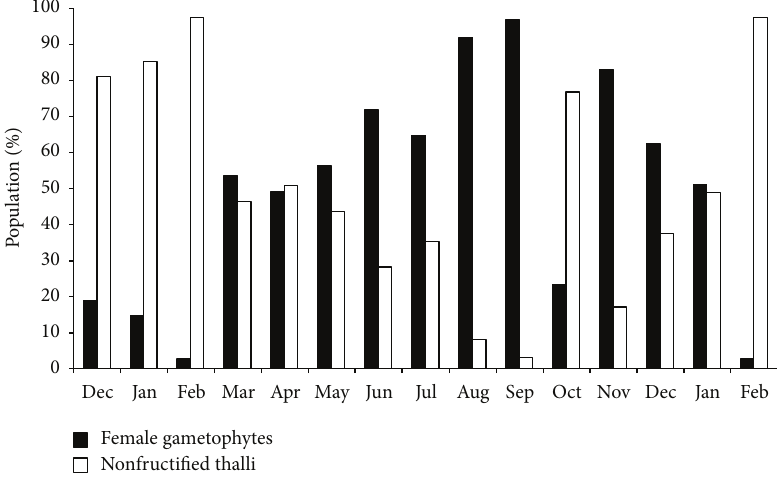
Figure 4: Population structure of Mastocarpus stellatus in Buarcos